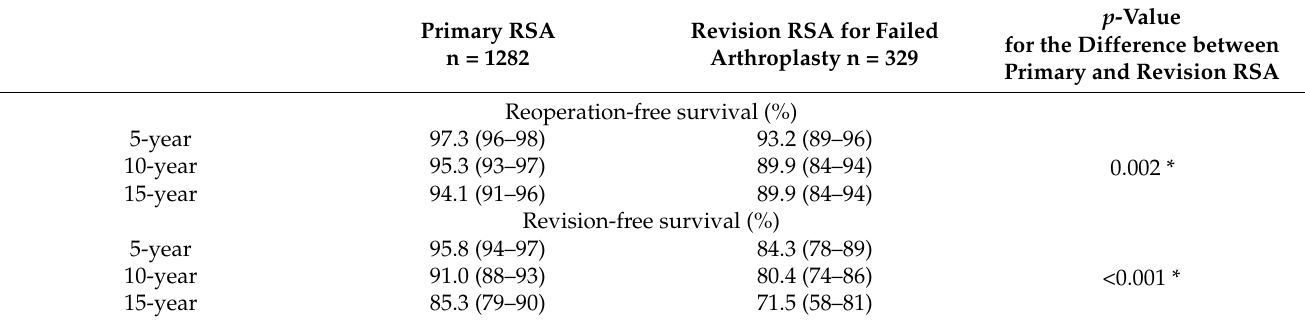
Table 3. Reoperation-free and revision-free or reintervention-free survivals in primary and revision RSA.